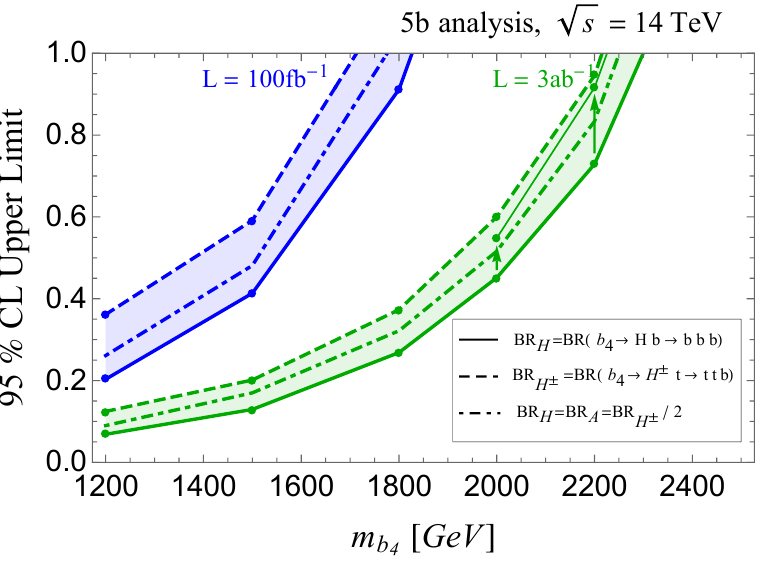
Figure 10 . Expected 95% CL upper limits on the b 4 branching ratio into neutral or charged Higgses in the 5b analysis. Styling of all curves matches that in (cid:12)gure 7.